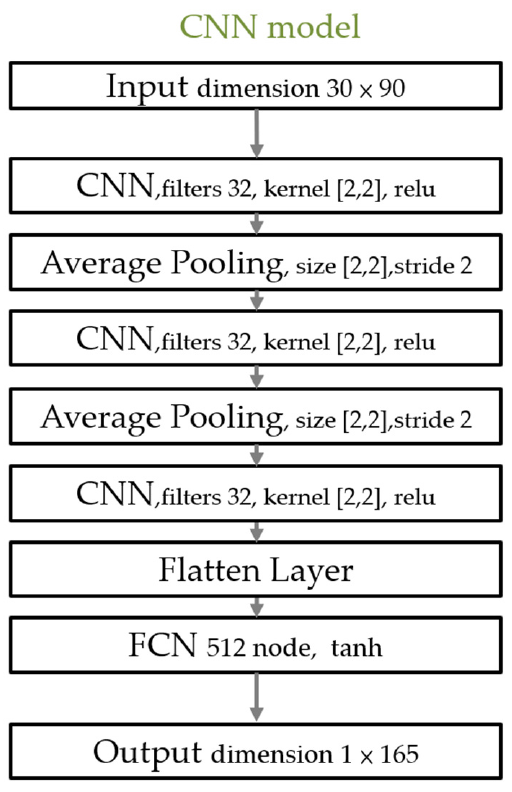
Figure 9. The model used in cross-validation for different pigs. Filter 32 indicates that the output depth of the CNN layer was 32. Tanh is the hyperbolic tangent that was used as an activation function. In Part II, each pig had its own geometry. To show how the model performed with different geometries, all recordings from each individual pig were used as a single data unit. Each pig’s data were used in turn as the validation data while the rest of the data were used as the training data. For example, there were 61 recordings from four pigs and 13 recordings from Pig 1. For the first cycle of cross-validation, 13 recordings from Pig 1 were used as validation data while the remaining 48 recordings were used for